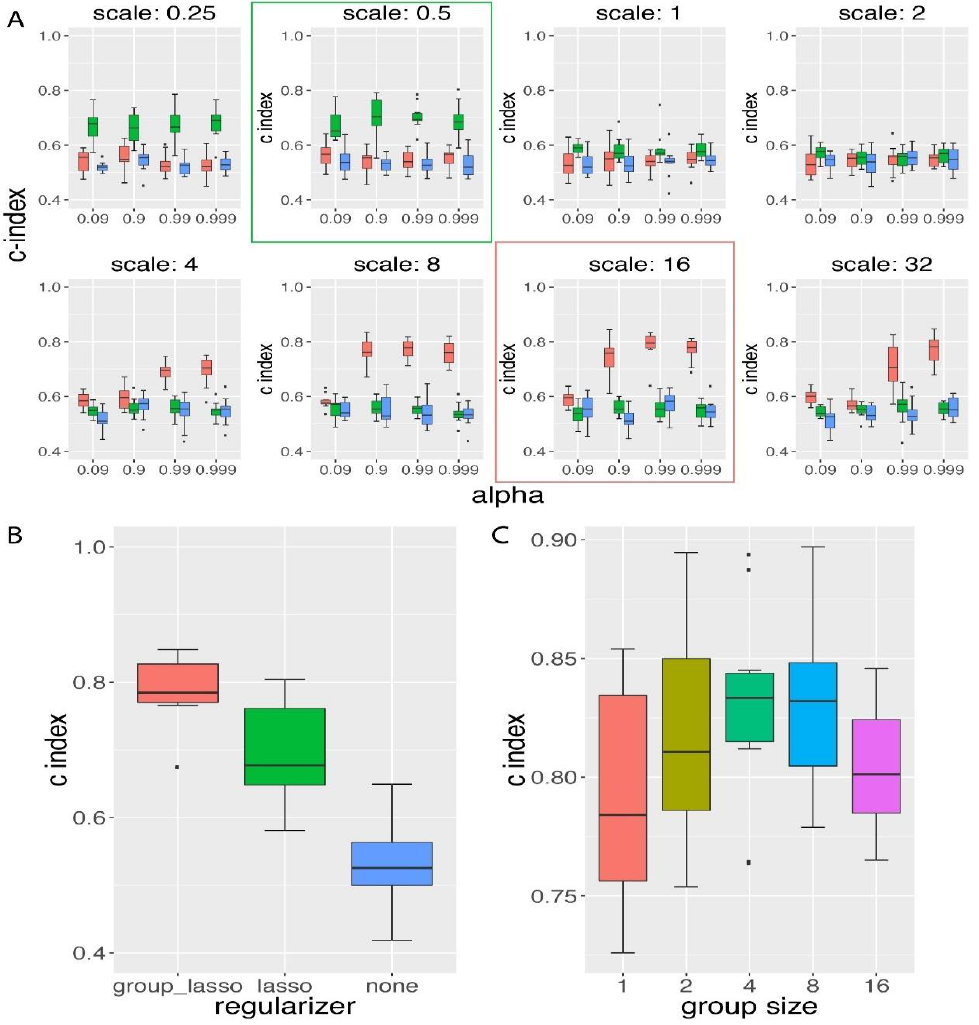
Figure 3. Group lasso regularization method achieved higher survival prediction accuracy than the lasso regularization method. ( A ) Grid search of the best hyper-parameters evaluated on validation data. GDP with group lasso regularization (red) was compared to both of GDP with lasso